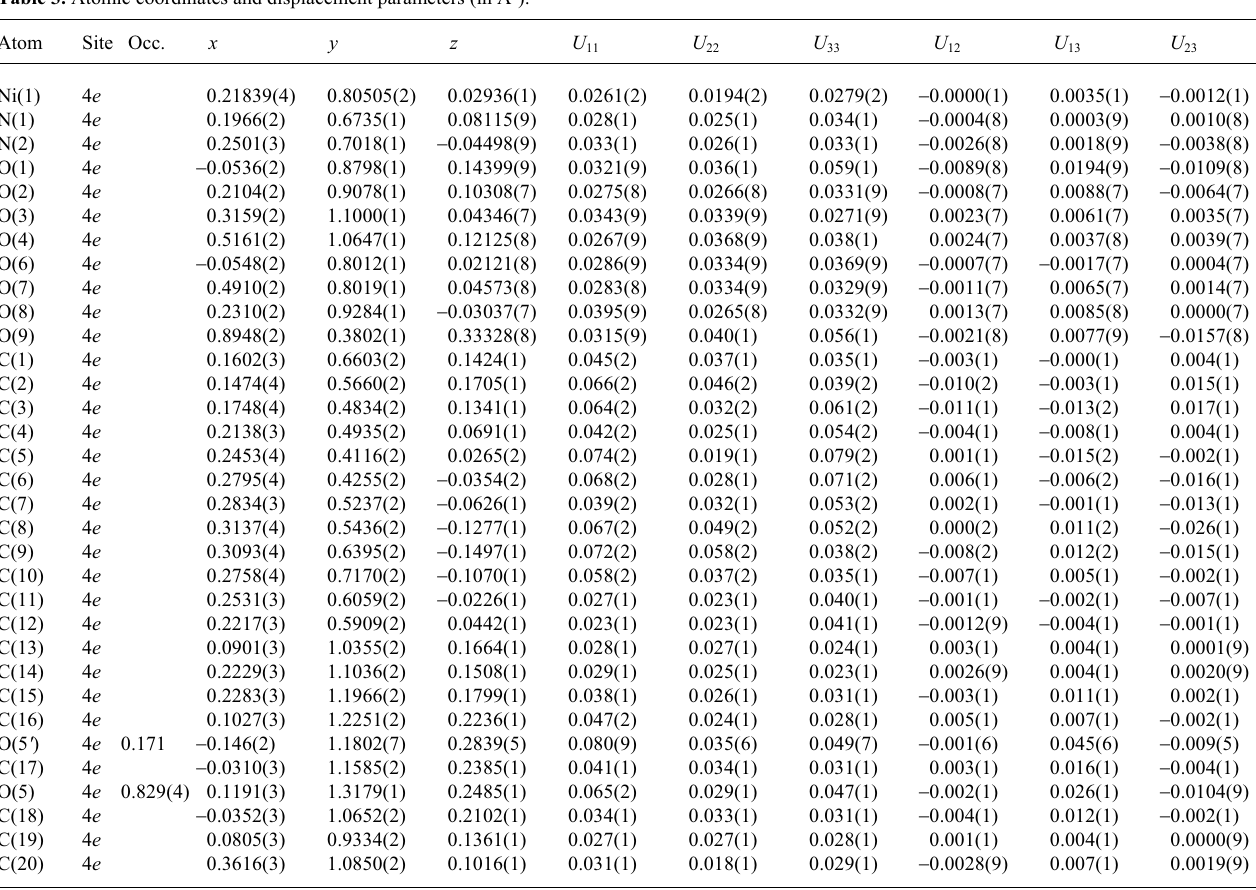
Table 3. Atomic coordinates and displacement parameters (in Å 2 ).